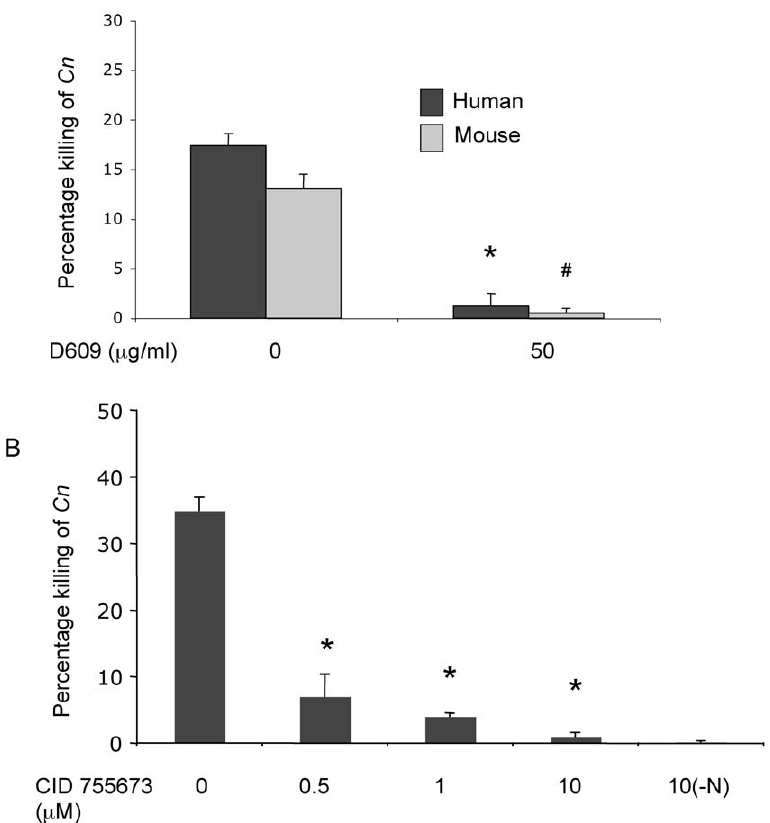
Figure 11. Effect of inhibitors on C.neoformans killing in the presence of neutrophils. ( A ) Effect of SMS inhibition on C. neoformans killing in the presence of neutrophils: 50 m g/ml D609 inhibits killing of C. neoformans in human and mouse neutrophils. *, P , 0.05, treated versus human untreated cells; # , P , 0.05, treated versus mouse untreated cells. ( B ) Effect of PKD1 inhibition (CID 755673) on killing of C. neoformans in the presence and in absence (-N) of human neutrophils. *, P , 0.05, treated versus untreated